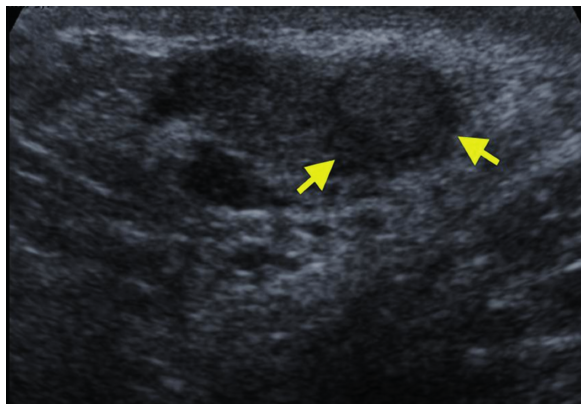
Figure 1 - A 1.5 cm well-defined hypoechoic solid nodule at the right epididymis coil (yellow